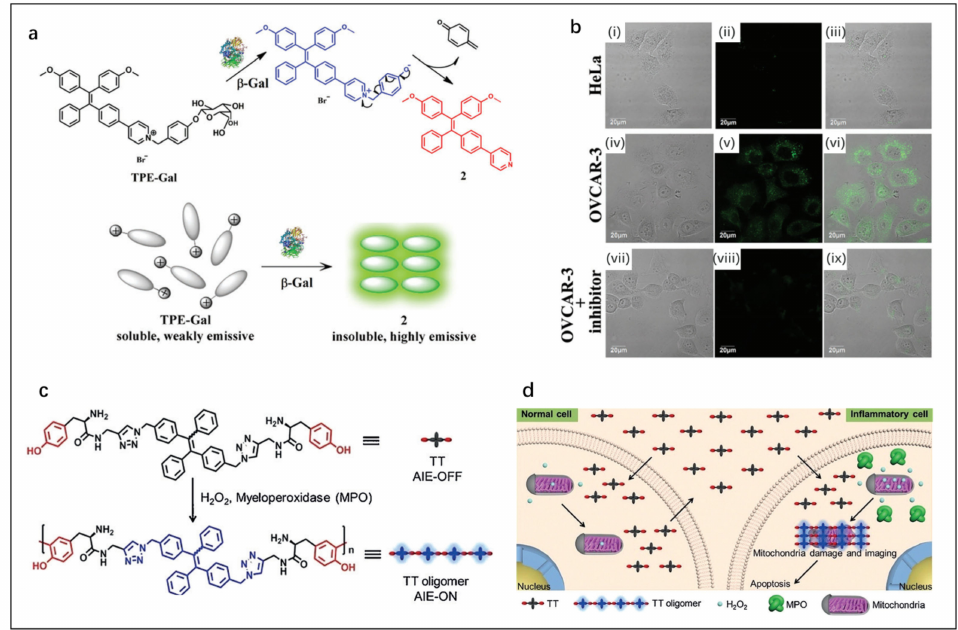
Figure 7. ( a ) Schematic representation of light-up sensing of β -gal. ( b ) Confocal fluorescence microscopy images of HeLa and OVCAR-3 cells incubated with TPE-Gal (10 mM) for 40 min: ( i – iii ) HeLa cells, ( iv – vi ) OVCAR-3 cells, and ( vii – ix ) OVCAR-3 cells pretreated with an inhibitor (50 mM) ( λ ex = 405 nm). Reproduced with permission from Ref. [77], copyright 2022, Royal Society of Chemistry. ( c ) Peroxidase-catalyzed oligomerization of TT in the presence of H 2 O 2 . ( d ) Selective imaging and inhibition of inflammatory cells after incubation of co-cultured cells with TT.